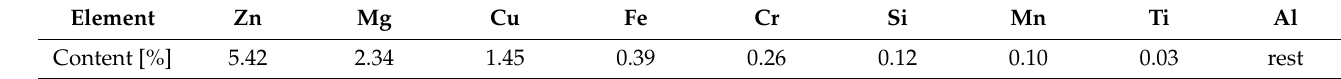
Table 1. Chemical composition of tested aluminum alloy